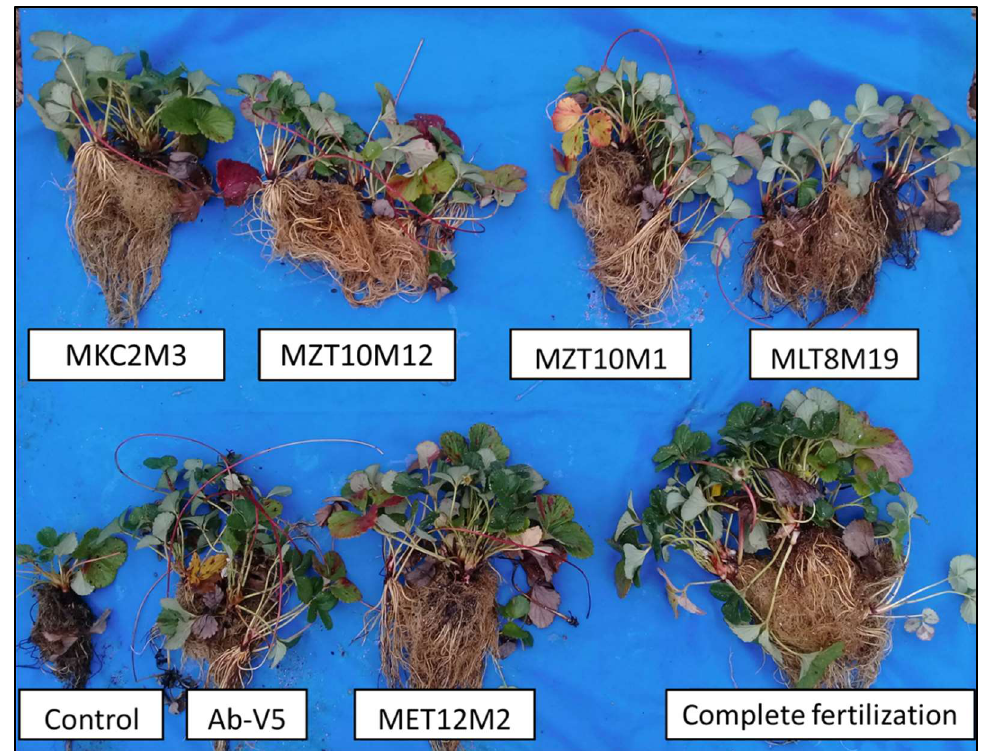
Figure 7. Growth of inoculated and non-inoculated strawberry plants. Data below each plant refer to the treatments applied. From left to right, and top: inoculation with isolate MKC2M3 ( Bacillus sp. Cereus clade), inoculation with MZT10M12 ( Paenibacillus sp.), inoculation with MZT10M1 ( Enterobacter sp.), inoculation with MLT8M19 ( Bacillus sp. Cereus clade), control with reduced N and P, inoculation with Ab-V5 ( Azospirillum brasilense ), inoculation with MET12M2 ( Brevibacillus fluminis ) and complete fertilization.